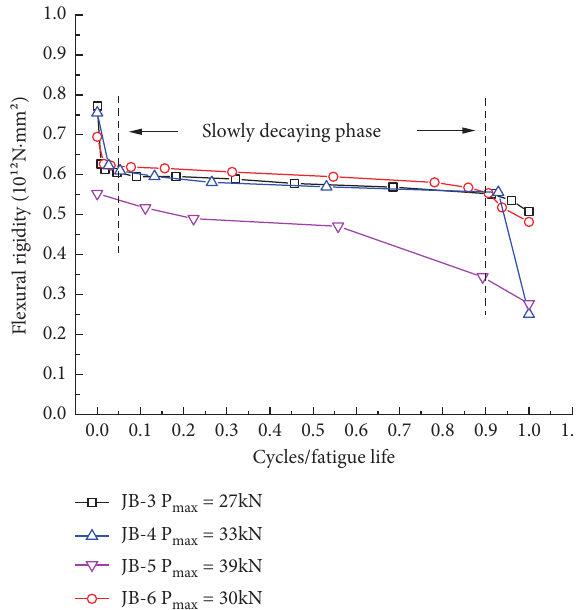
Figure 12: Flexural stiffness attenuation curve of reinforced beam section.